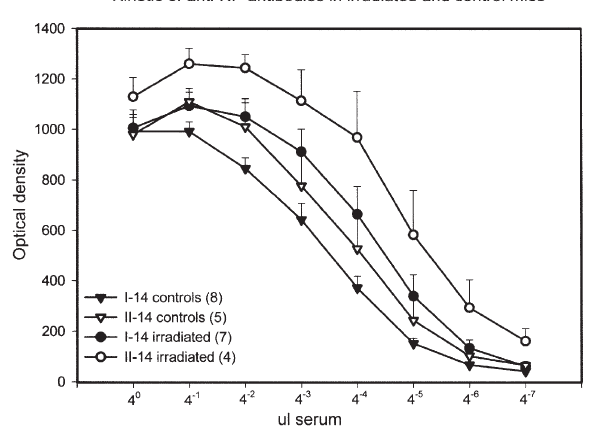
FIGURE 4 Increased anti-NP antibody response in RX-P.S. mice following irradiation. Sera from groups of 4 to 8 RX-P.S. (circle) and non- RX (triangle) mice immunized with NP-KLH precipitated in Alum were collected at day 14 (I-14, closed circle and triangle) and 14 days after the second stimulation with NP-KLH in PBS (II-14, open circle and triangle). Results represent mean ^ SEM : Shown are Igs sera binding curves using NP 17 -BSA. Number into brackets indicates number of mice.